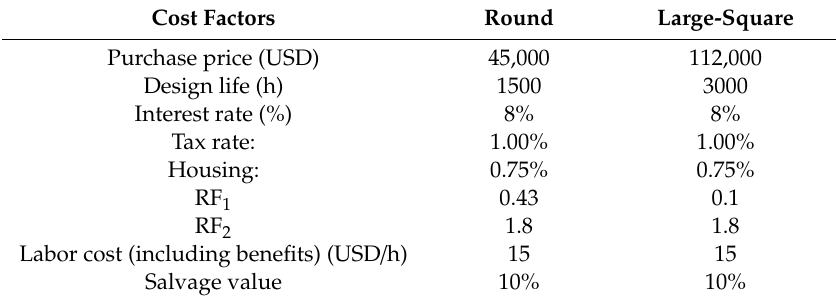
Table 1. Machinery cost factors for the balers using the notation and definitions given in ASABE Standard